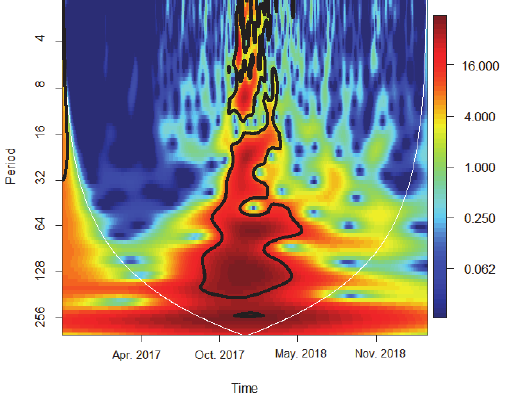
Fig. 5. Power Spectrum for Bitcoin Fig. 6. Power Spectrum for Etherium